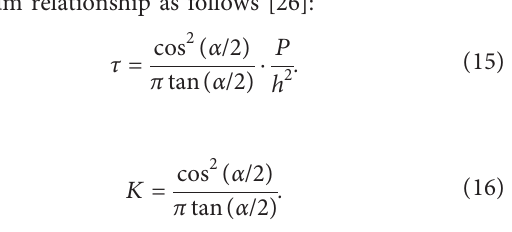
Figure 2: Mechanical analysis of